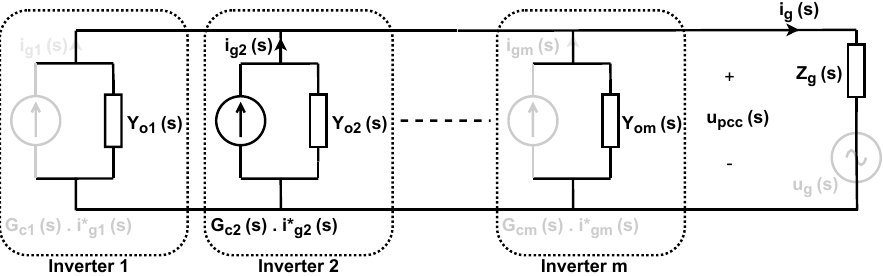
Figure 4. Admittance model for contributions from all of the other parallel connected inverters.